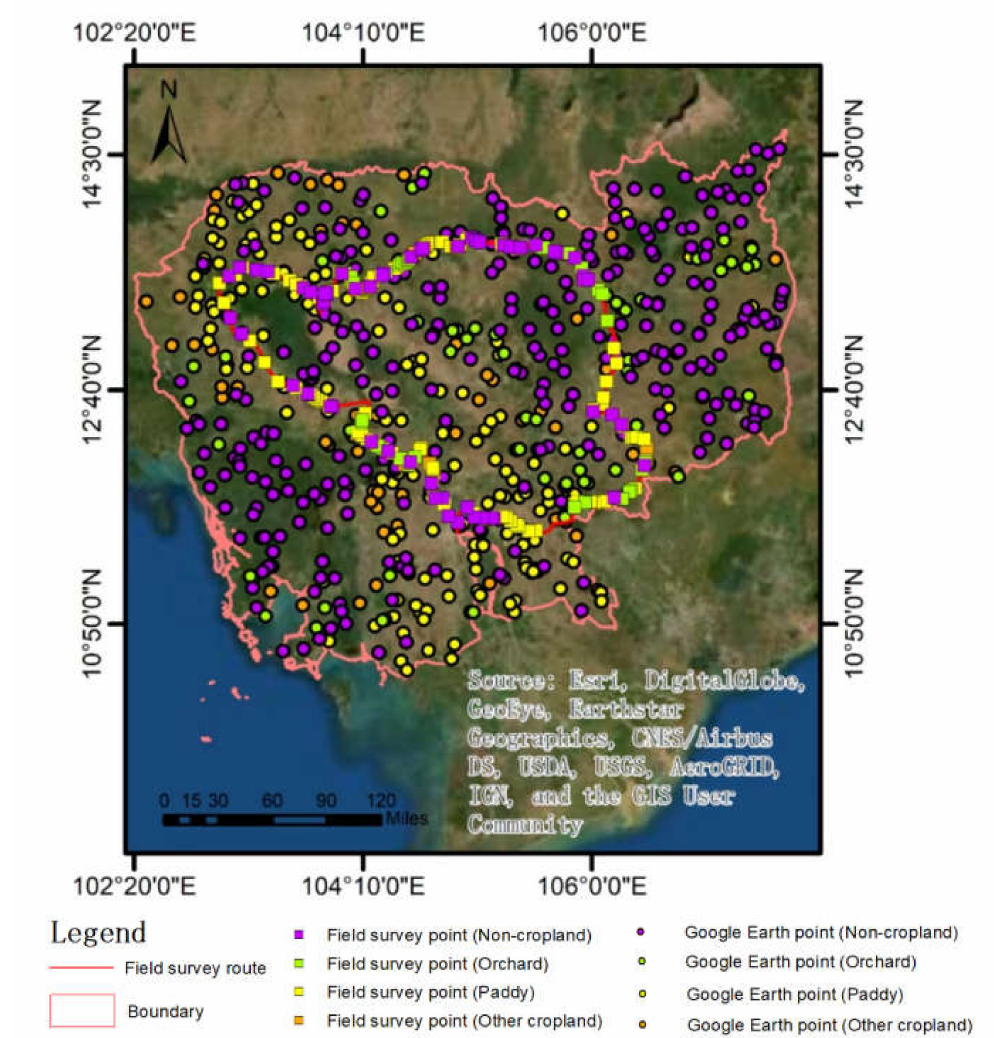
Figure 9. Spatial distribution of verification samples in the study